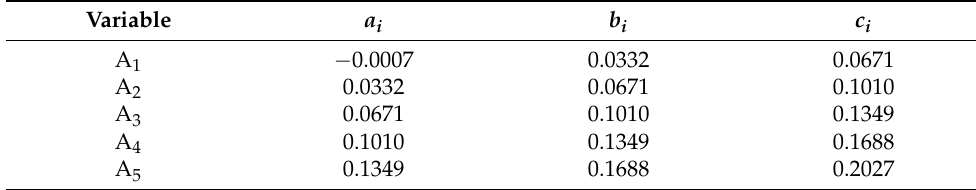
Table 17. Variables obtained by quantification.